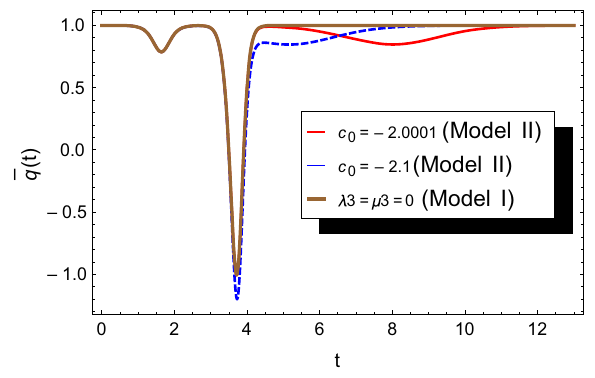
Fig. 9 Acceleration parameter evolution for different values of the c 0 parameterwith λ 1 = 2 . 70, λ 2 = 3 . 23, and α 1 = α 2 = − 5 . 9. The (blue) dotted and (red) thin lines stands for λ 3 = μ 3 = 0 .